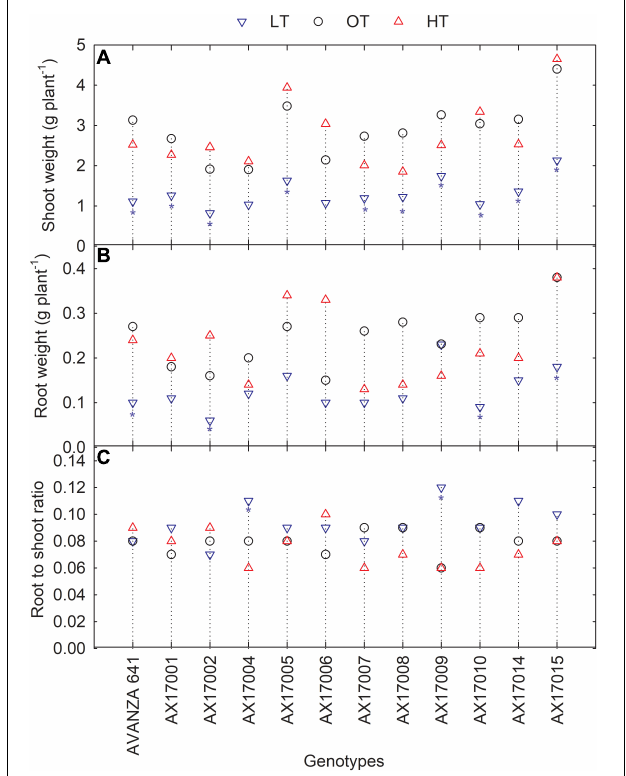
FIGURE 4 | Line plots showing the phenotypic variations in shoot weight (A) , root weight (B) , and root to shoot ratio (C) of 12 carinata genotypes measured 35 days after planting or 24 days after temperature treatments imposition. The dotted middle line indicates the average trait of 12 genotypes under optimum temperature. LT, low temperature; OT, optimum temperature; and HT, high temperature. Asterisk indicates a significant difference between the temperature treatments (blue – between LT and OT; red – between HT and OT) in a genotype at 5% LSD.